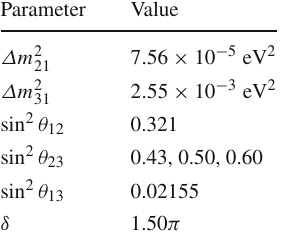
Table 5 Oscillation parameters used to simulate neutrino and antineutrino data for the DUNE CPT sensitivity analysis